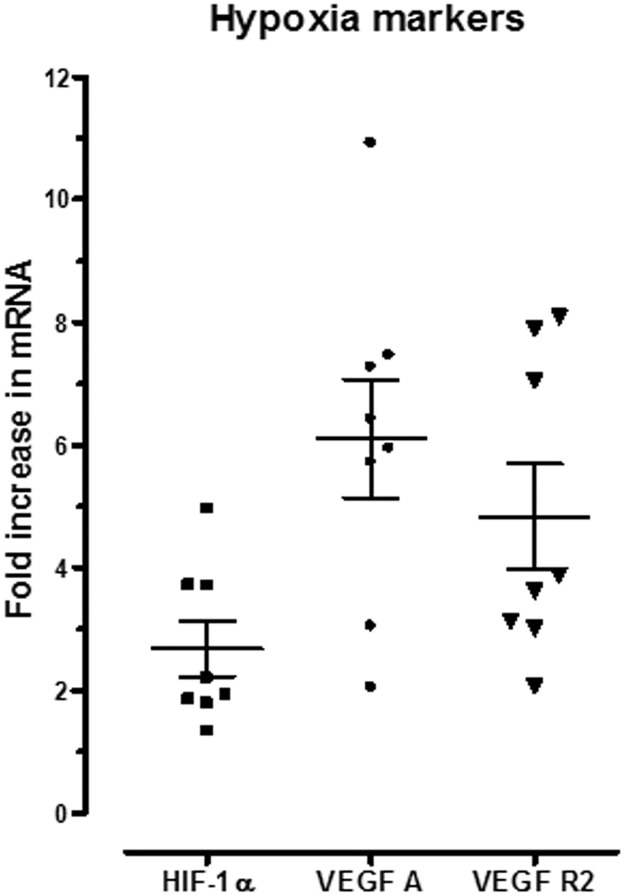
Expression of hypoxia markers in placenta from IUGR 22-day pregnant rats compared to their controls.Relative placental mRNA expression of HIF-1α, VEGFA and VEGFR2 in placenta from term IUGR placenta. Each point represents one placenta. Ct average of each duplicate was calculated for each gene and 18S and the ΔCT (CTgene—CT18S) was determined. The control placental tissue sample was chosen as a reference sample and set as 100% of gene quantity. The mRNA abundance of the placenta was calculated with the formula 2-ΔΔCT. Results are expressed as means ± SEM. (n = 8 rats/genes). * P<0.05, one sample Student’s t test.